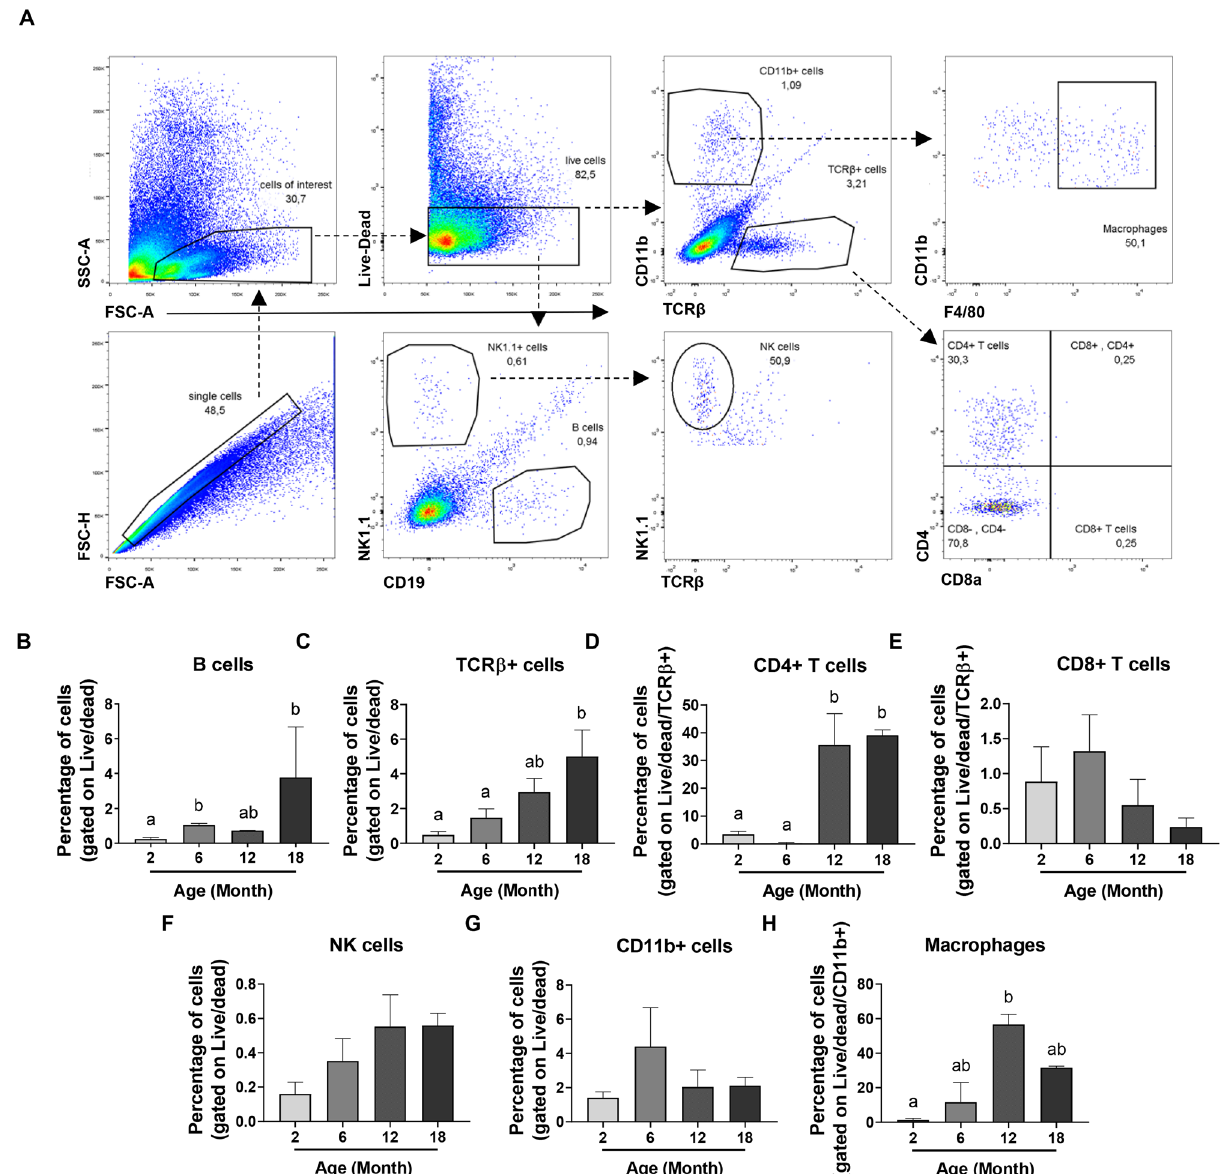
Figure 6. Ovarian immune cell populations increase during reproductive ageing. ( A ) Gating strategy used to identify different immune cell populations in ovaries from 2, 6, 12 and 18-month-old mice. Percentage of B cells ( B ), T cells ( C ), CD4 + ( D ) and CD8 + T cells ( E ), NK1.1 + TCRβ- NK cells ( F ), CD11b + cells ( G ) and F4/80 + CD11b + macrophages ( H ) present in ovaries from 2, 6, 12 and 18-month-old mice. n = 3–5 per cohort. Data are presented as mean ± SEM; ( B , F , G , H ): Kruskal–Wallis test, Dunn’s multiple comparisons test: a and b are significantly different among groups ( p < 0.05); ( C , D , E ): Ordinary One-way ANOVA, Tukey’s multiple comparisons test: a and b are significantly different among groups ( p <